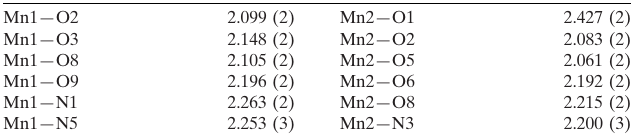
Selected bond lengths (A˚ ).